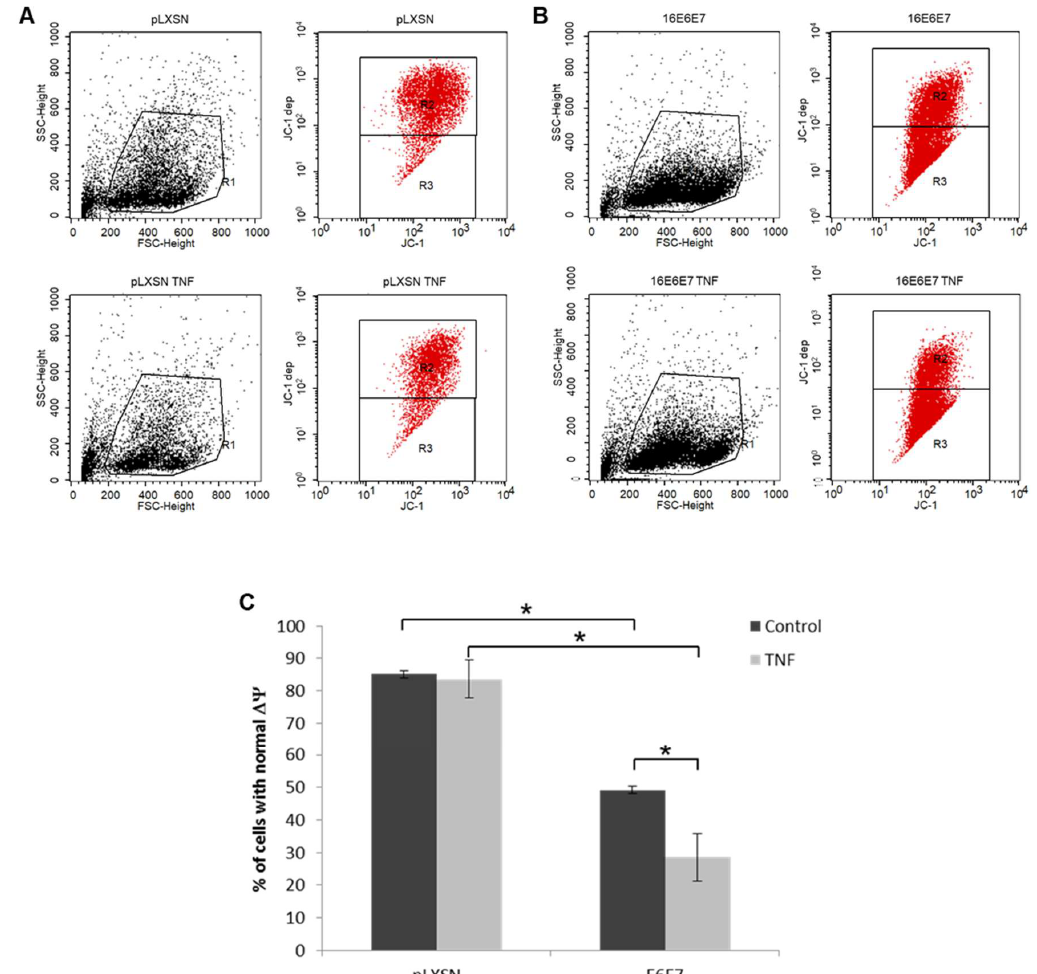
Figure 6. Human keratinocytes expressing HPV16 E6 and E7 exhibit alterations in mitochondria membrane potential ( ∆Ψ membrane potential (Δ Ψ ). The status of mitochondria membrane potential was analyzed in monolayer cultures of ( A ) control (pLXSN) and ( B ) HPV16 E6 and E7 expressing PHKs before and after treatment with TNF using the BD™ MitoScreen Flow Cytometry Mitochondrial Membrane Potential Detection Kit according to the manufacturer’s instructions. Mitochondria membrane potential was determined by flow cytometry by measuring fluorescence emission by JC-1 (5,5′,6,6′- tetrachloro-1,1′,3,3′-tetraethylbenzimidazolocarbo-cyanine iodide) in the red channel. This is a cationic cyanine dye that accumulates in mitochondria with preserved Δ Ψ . The percentage of cells with normal membrane potential is quantified in ( C ). The results presented are representative of three independent experiments. Statistical differences between samples were determined by Student’s t - test (* p -value ≤0.05).